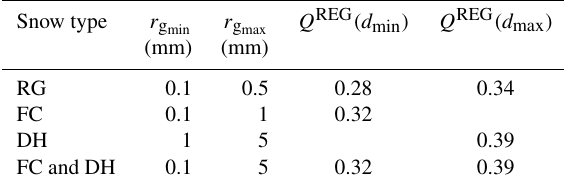
Table A2. Parameters of the ANISO adaptation; Eq. (A1).